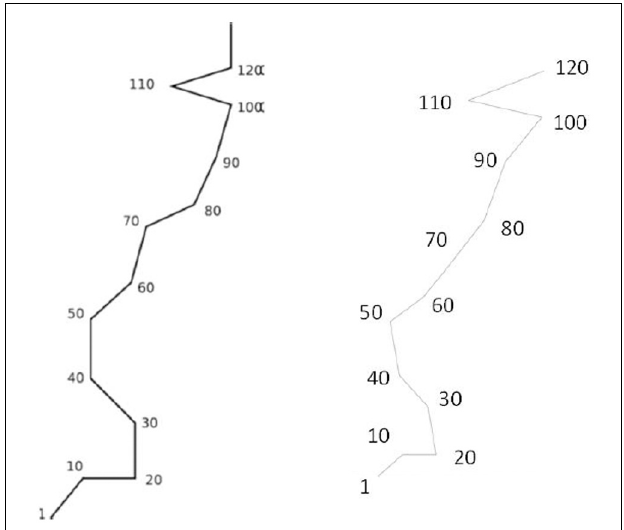
FIGURE 1 | AB’s number form as produced at the start of the investigation (left) and 22 months later (right).